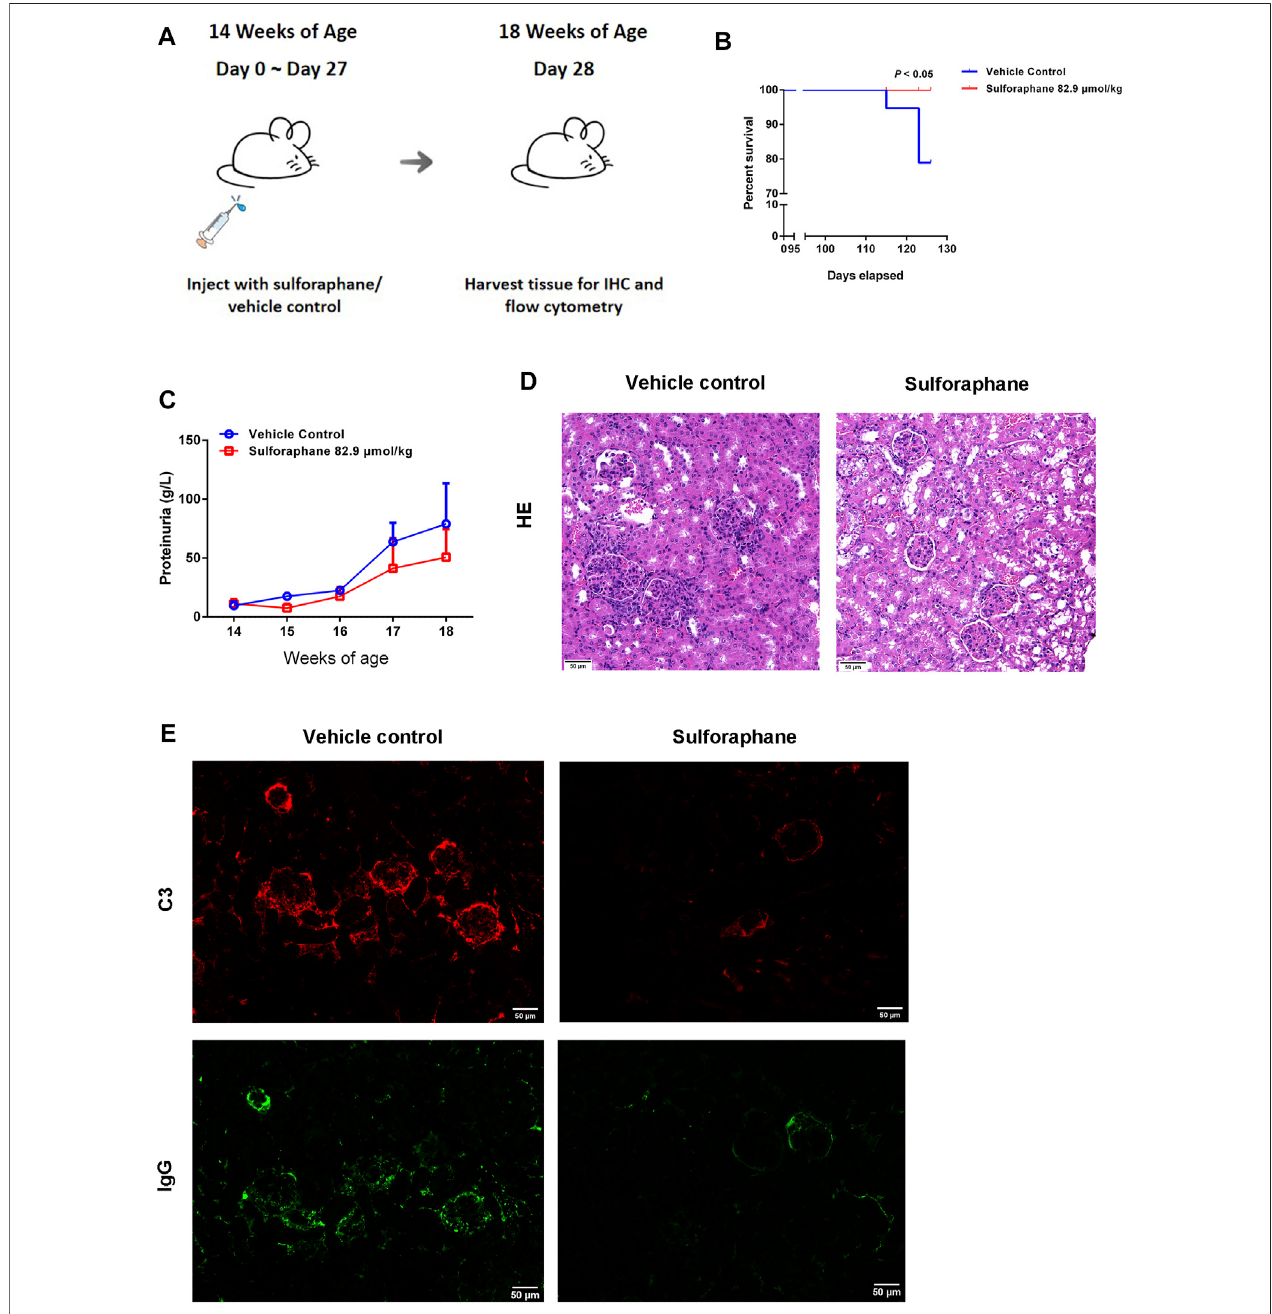
FIGURE 3 | Sulforaphane alleviates renal damage in lupus-prone MRL/lpr mice. (A) Schematic diagram of the administration of sulforaphane (82.9 μ mol/kg) or vehiclecontrolfor27consecutivedaysinMRL/lprmiceattheageof14 weeks(n (cid:1) 5 – 6). (B) ThelifespanofMRL/lprmicetreatedwithsulforaphaneorvehiclecontrol. (C) The changes of urine protein levels in MRL/lpr mice treated with sulforaphane or vehicle control. (D) Renal pathology was examined by immunohistochemistry of haematoxylin-eosin staining (H&E) in MRL/lpr mice treated with sulforaphane or vehicle control. Scale bars: 50 µm. (E) C3 and IgG deposition in kidney sections was examined by immuno fl uorescence staining in MRL/lpr mice treated with sulforaphane or vehicle control. Scale bars: 50 µm.